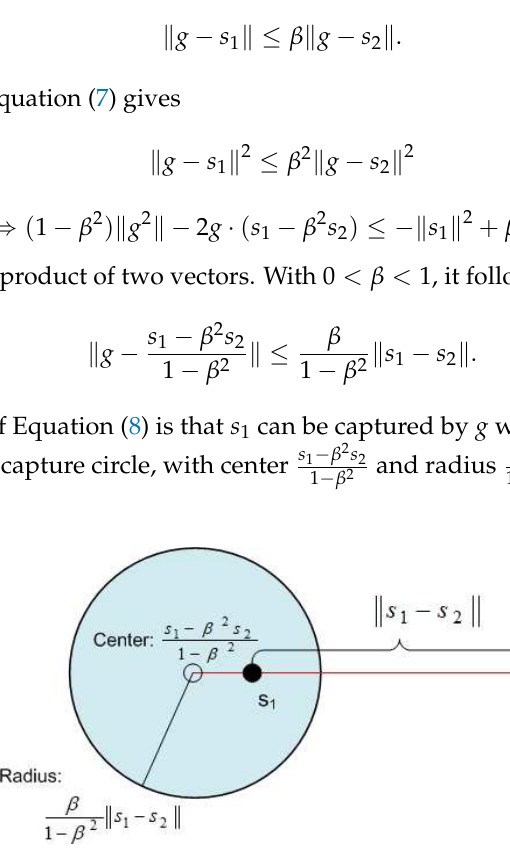
Figure 2. The capture region defined by center and radius, based on SN pair ( s 1 , s 2